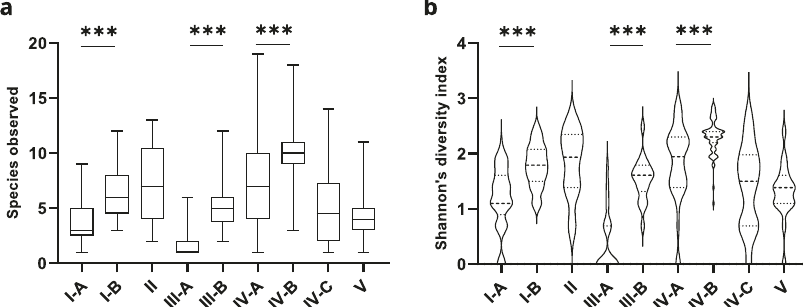
Fig. 2 Microbial richness and diversity associate with novel microbiome pro fi les. a Analysis of species richness shows a signi fi cantly higher number of species in samples classi fi ed as CSTs I-B, III-B, and IV-B compared to I-A, III-A, and IV-A, respectively. b Analysis of diversity demonstrates a signi fi cantly higher diversity in samples classi fi ed as CSTs I-B, III-B, and IV-B compared to I-A, III-A, and IV-A, respectively, as evaluated by Shannon ’ s index. Error bars represent means ± s.d. and differences in richness and diversity were analyzed by using a Mann – Whitney U test followed by Bonferroni correction. *** p < 0.0001. Source data are provided as a Source data fi le.